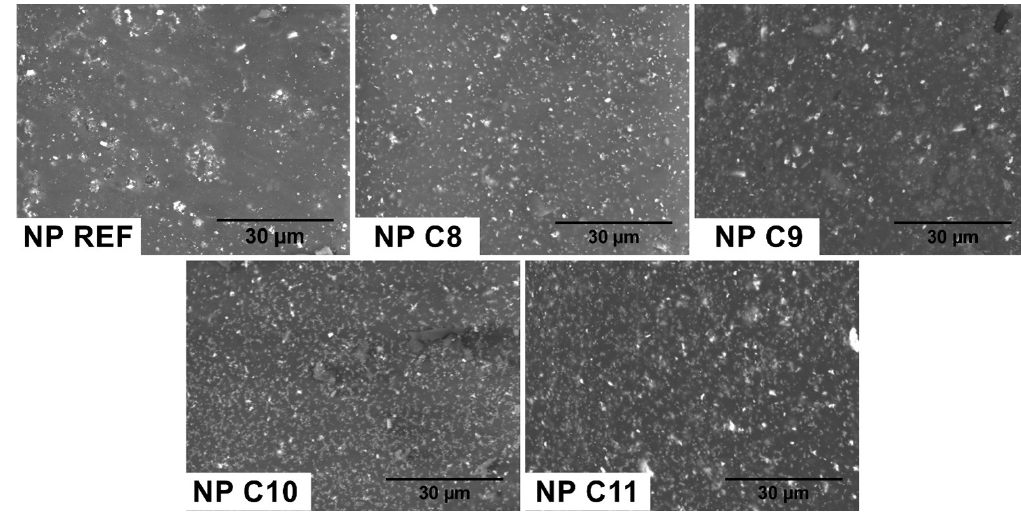
O paint (NP) samples exposed to in-situ 2 5